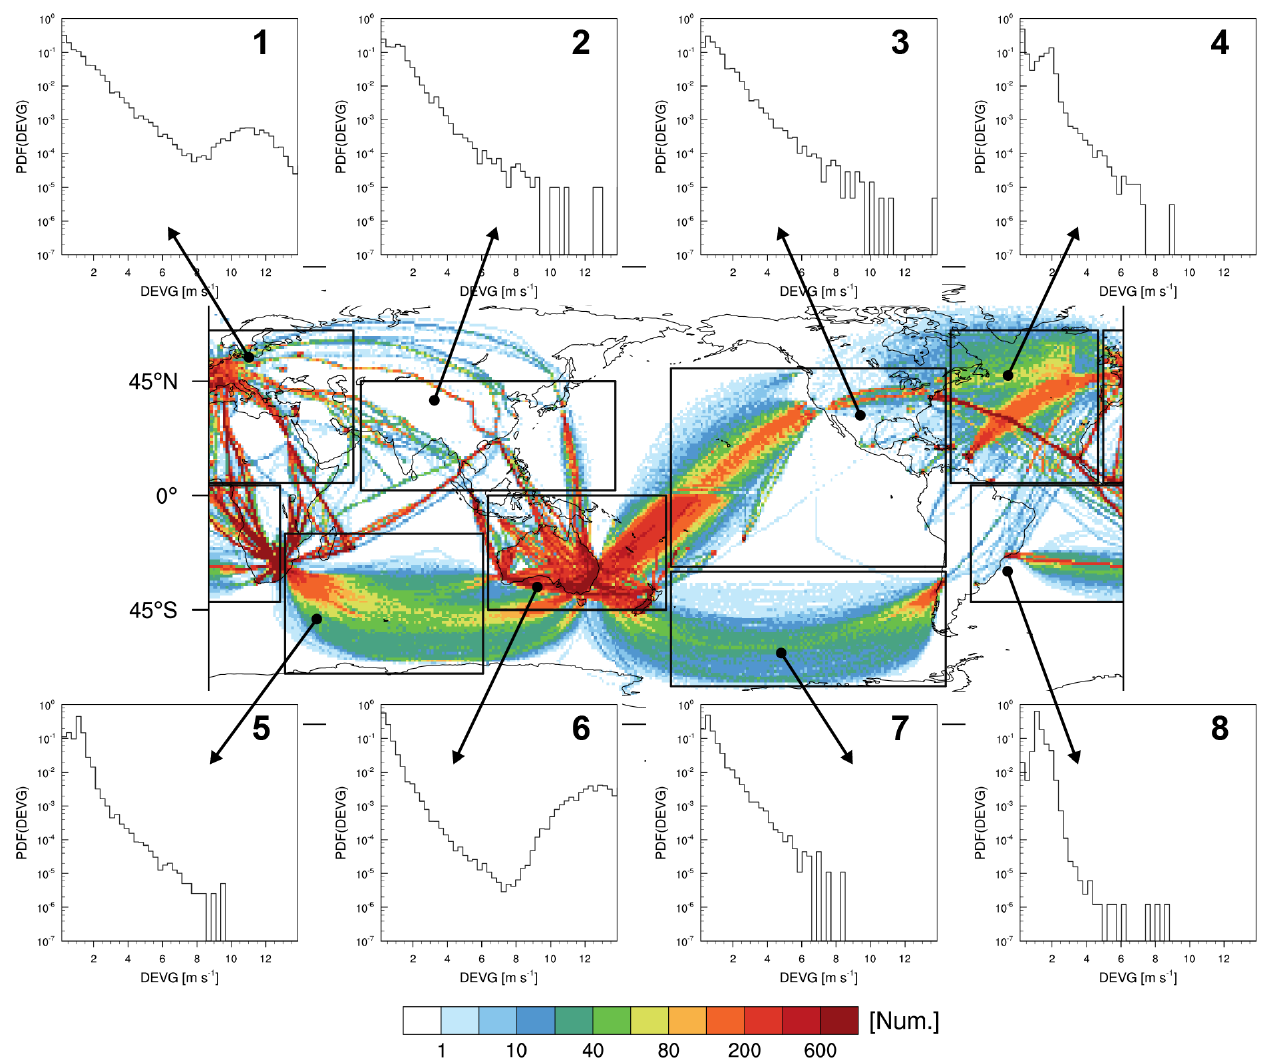
Figure 4. The PDFs of the raw DEVG over eight selected regions, which are indicated as rectangles in the global map, at altitudes above 15kft ( ∼ 4 . 57km) from October 2015 to September 2018. The eight regions are located in 8 ◦ S–57 ◦ N, 5–65 ◦ E (region 1); 2–45 ◦ N, 60– 160 ◦ E (region 2); 28 ◦ S–50 ◦ N, 70–178 ◦ W (region 3); 5–65 ◦ N, 10–68 ◦ W (region 4); 15–70 ◦ S, 30–108 ◦ E (region 5); 0–45 ◦ S, 110–180 ◦ E (region 6); 30–75 ◦ S, 70–178 ◦ E (region 7); and 42 ◦ S–4 ◦ N, 60 ◦ W–28 ◦ E (region